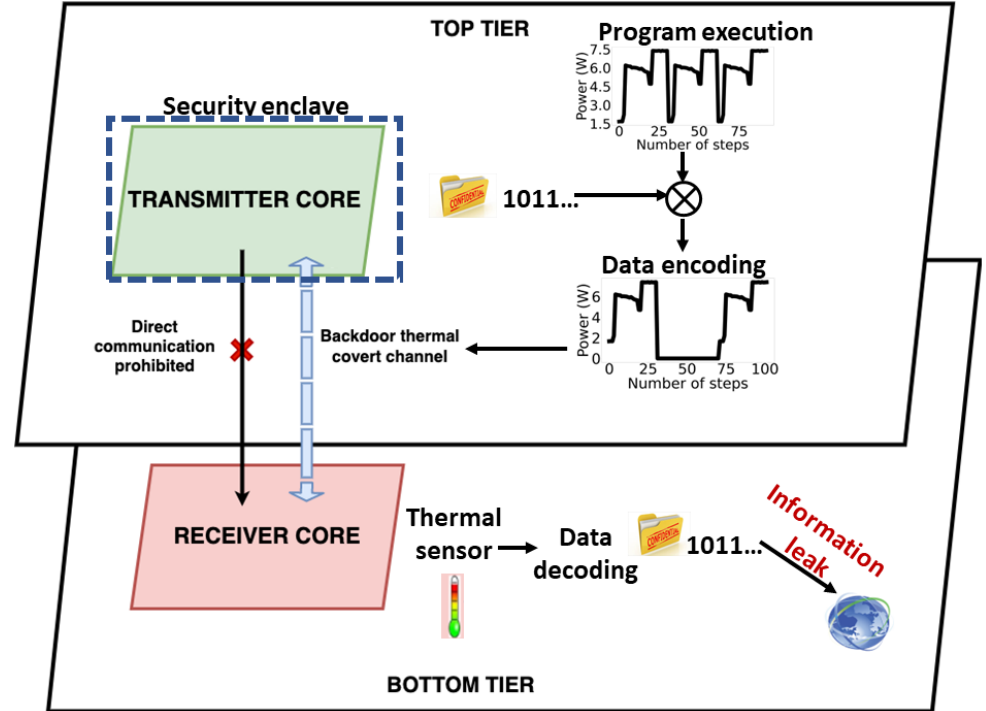
Figure 7. Attack model of a thermal covert channel between a secure and insecure chiplet in a 3D